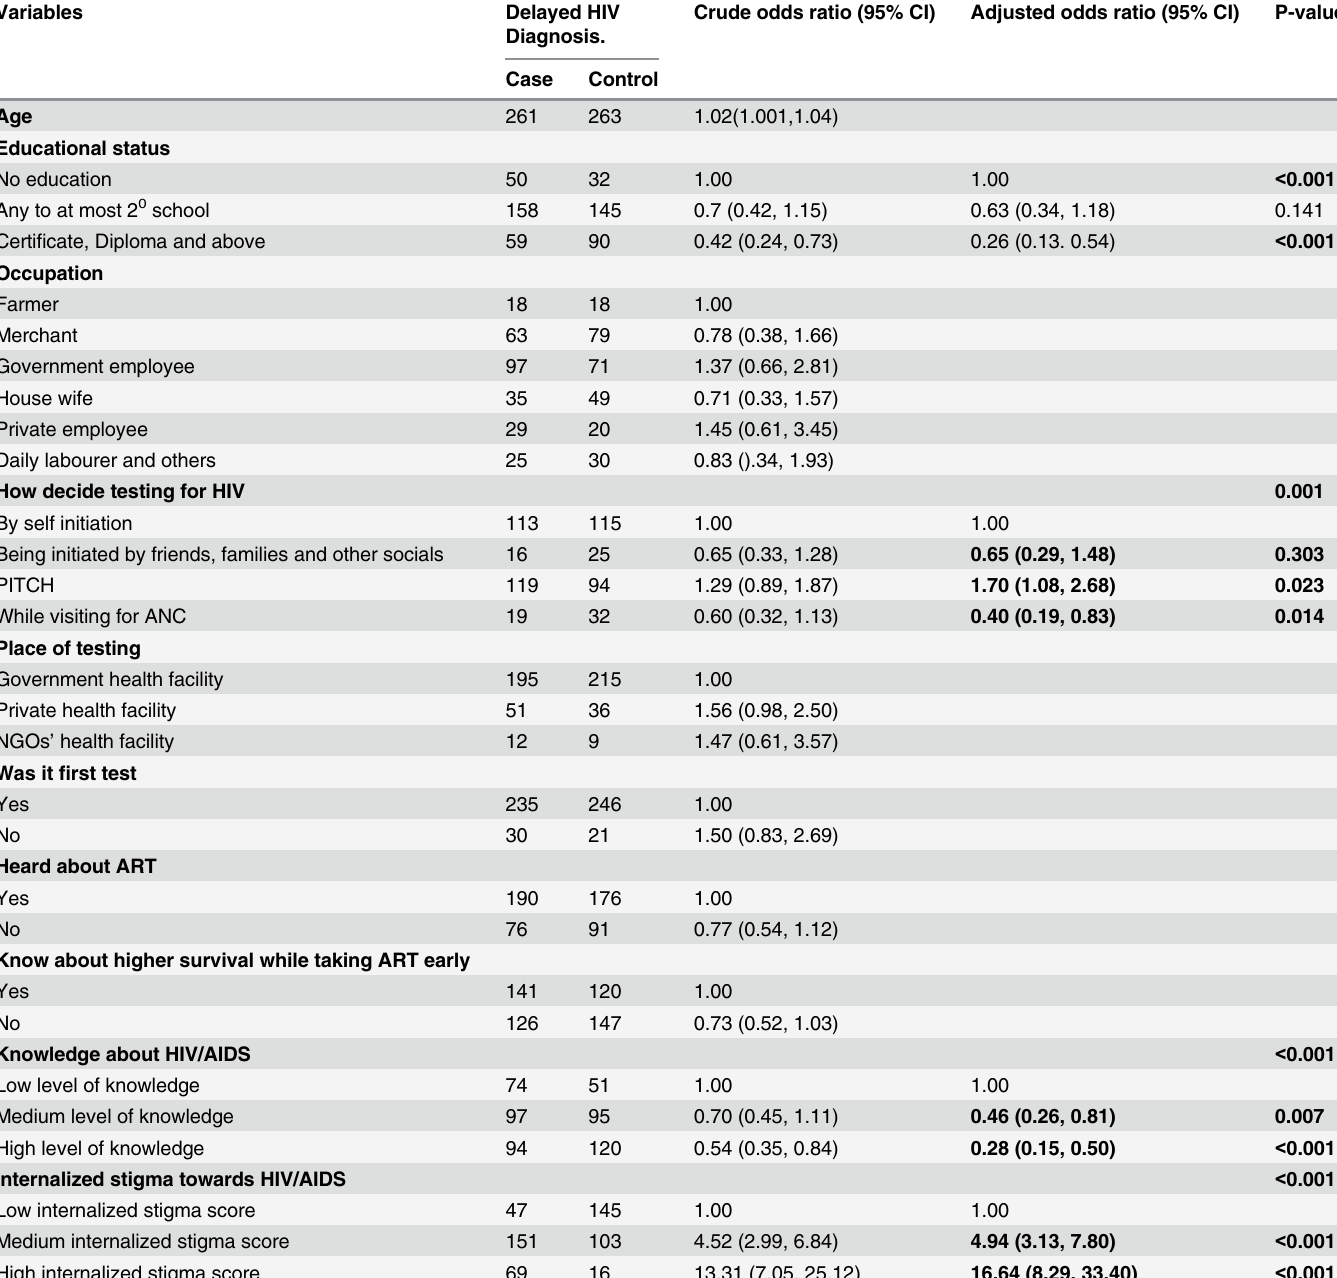
Table 3. Factors associated with delayed diagnosis of HIV among Adult PLHA who had undertaken initial CD4 count at Bahirdar FHRH from Janu- ary 2010 to December 2011.